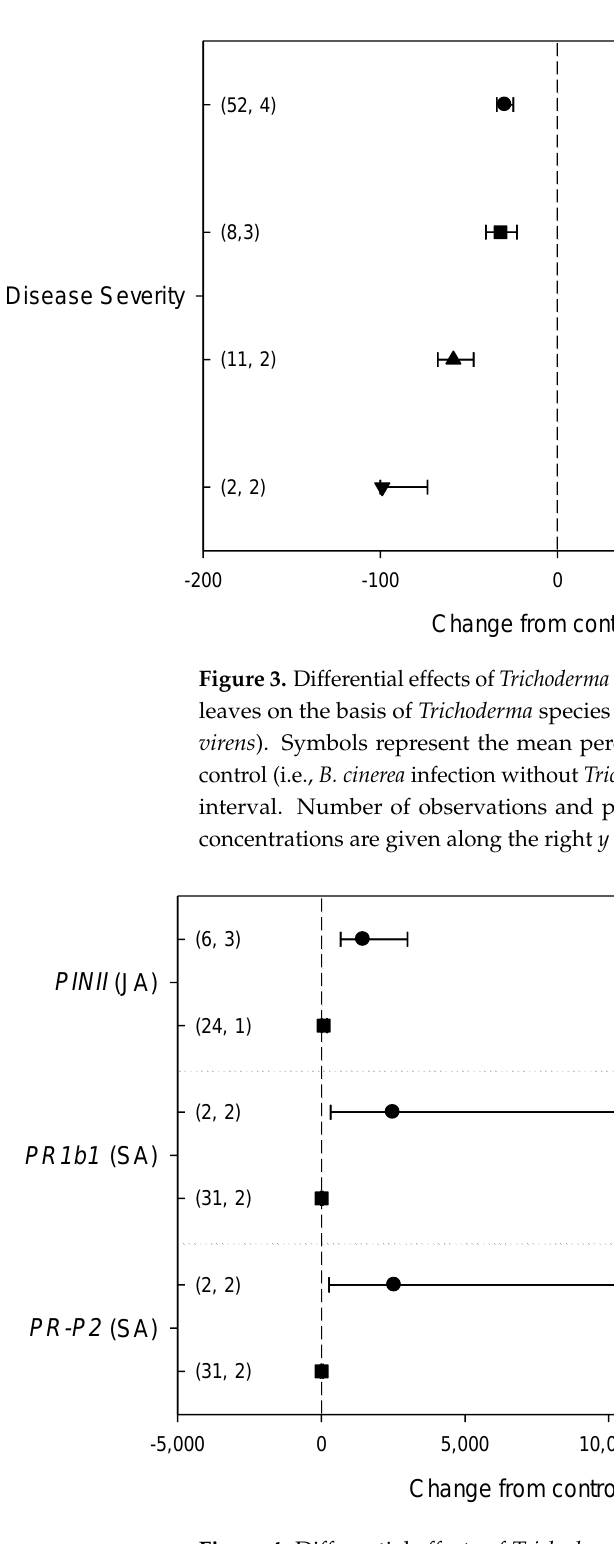
Figure 5. Differential effects of Trichoderma on Botrytis cinerea infection (i.e., disease intensity) and defense-related genes involved in jasmonic (JA; i.e., proteinase inhibitors II, PINII ) and salicylic acid (SA; pathogenesis-related 1b1 and P2, PR1b1 and PR-P2 ) pathways in tomato leaves on the basis of duration of B. cinerea infection (0 – 3, 4 – 7, 8 – 14 and >14 days of infection, DOI). Symbols represent the mean percentage change due to Trichoderma treatment relative to control (i.e., B. cinerea infection without Trichoderma treatment), and the bars show the 95% confidence interval. Number of obser- vations and papers are shown in parentheses; mean Trichoderma spp. concentrations are given along the right y axis.